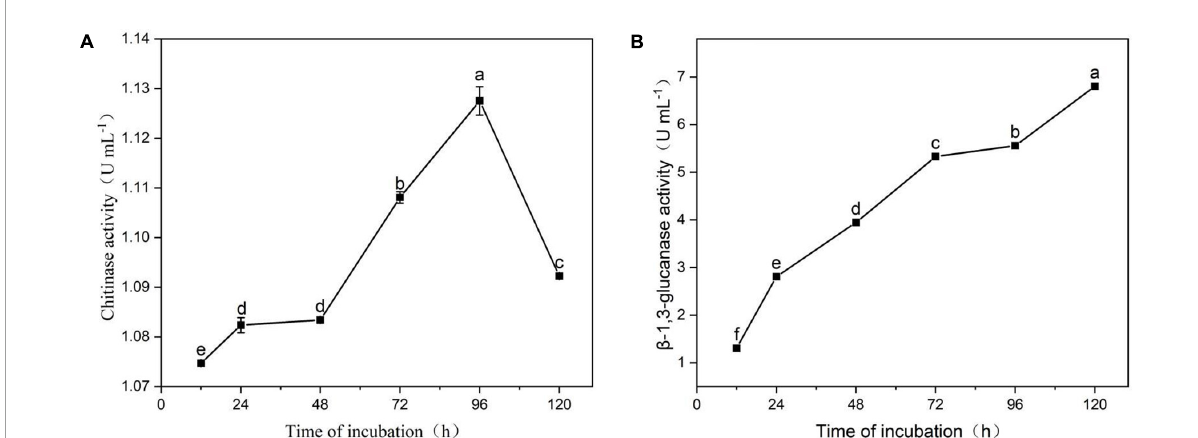
FIGURE8 Extracellular chitinase (A) and β -1, 3-glucanase (B) activity by strain YYC 155. Three duplicates were measured for YYC 155 at each time point and were measured three times for each replicate. Data represent the mean ± standard error (se). Different letters represent a significant difference in enzyme activity between the different timepoints as determined by Duncan’s multiple range test ( P < 0.05).